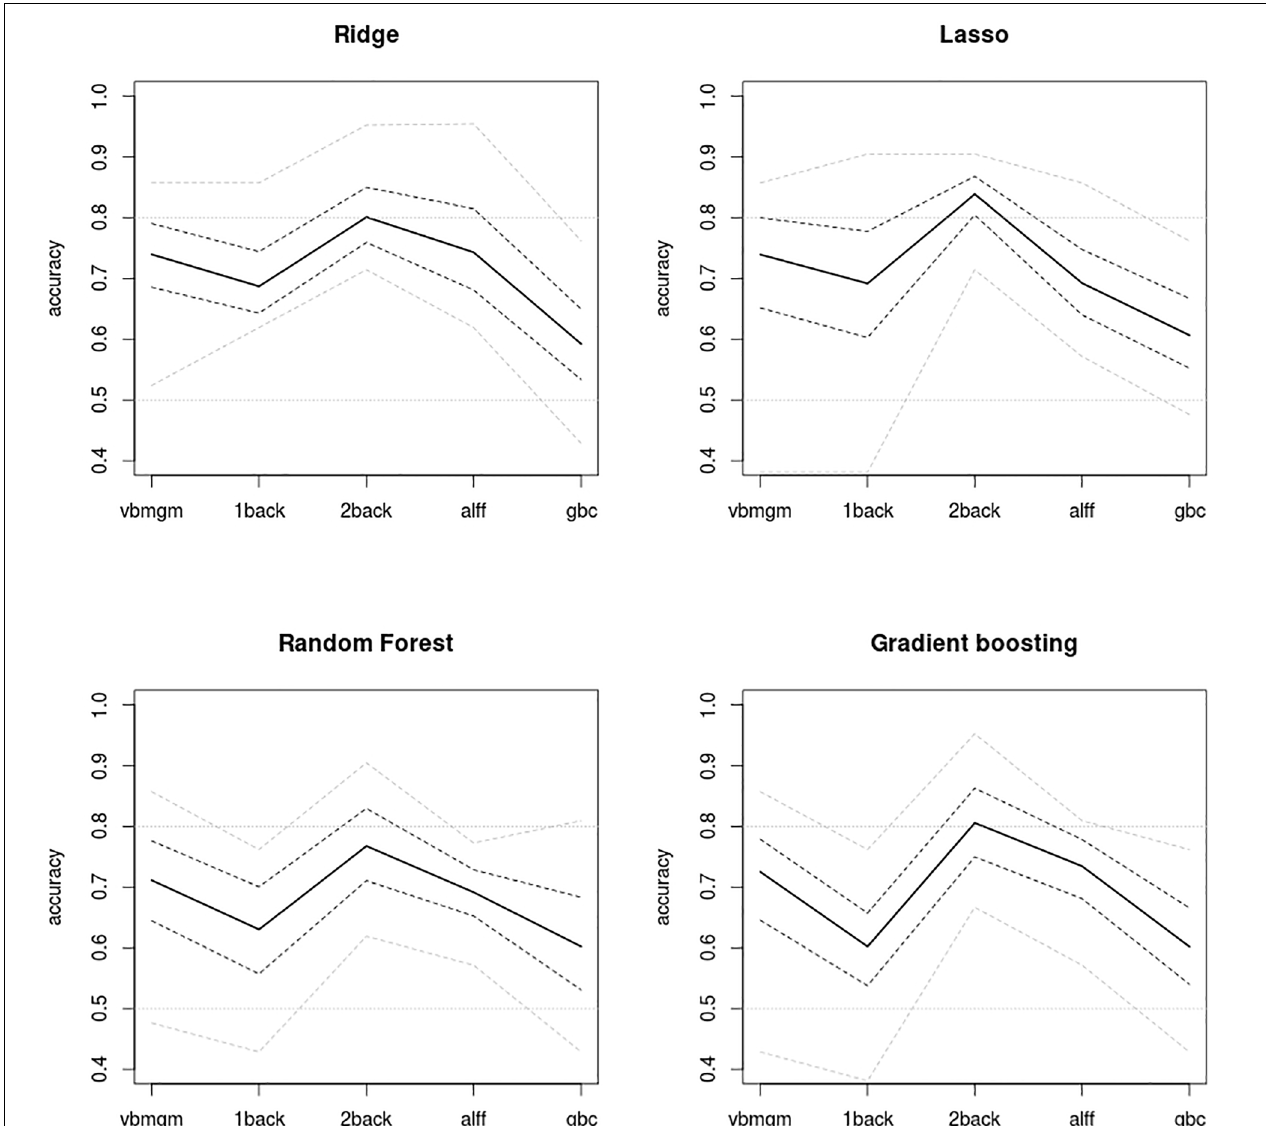
FIGURE 2 | Plots of accuracy levels achieved by the four unimodal algorithms applied to the five brain maps. Mean accuracies extracted from test samples are shown by a continuous line. 2back maps show the strongest predictive power using all algorithms and GBC maps deliver the weakest. Gray dashed lines, 95% bootstrap intervals of mean accuracies and gray dotted lines, maximum and minimum accuracies delivered by the 10-fold scheme. 0.5 accuracy indicates chance accuracy (no real predictive power).